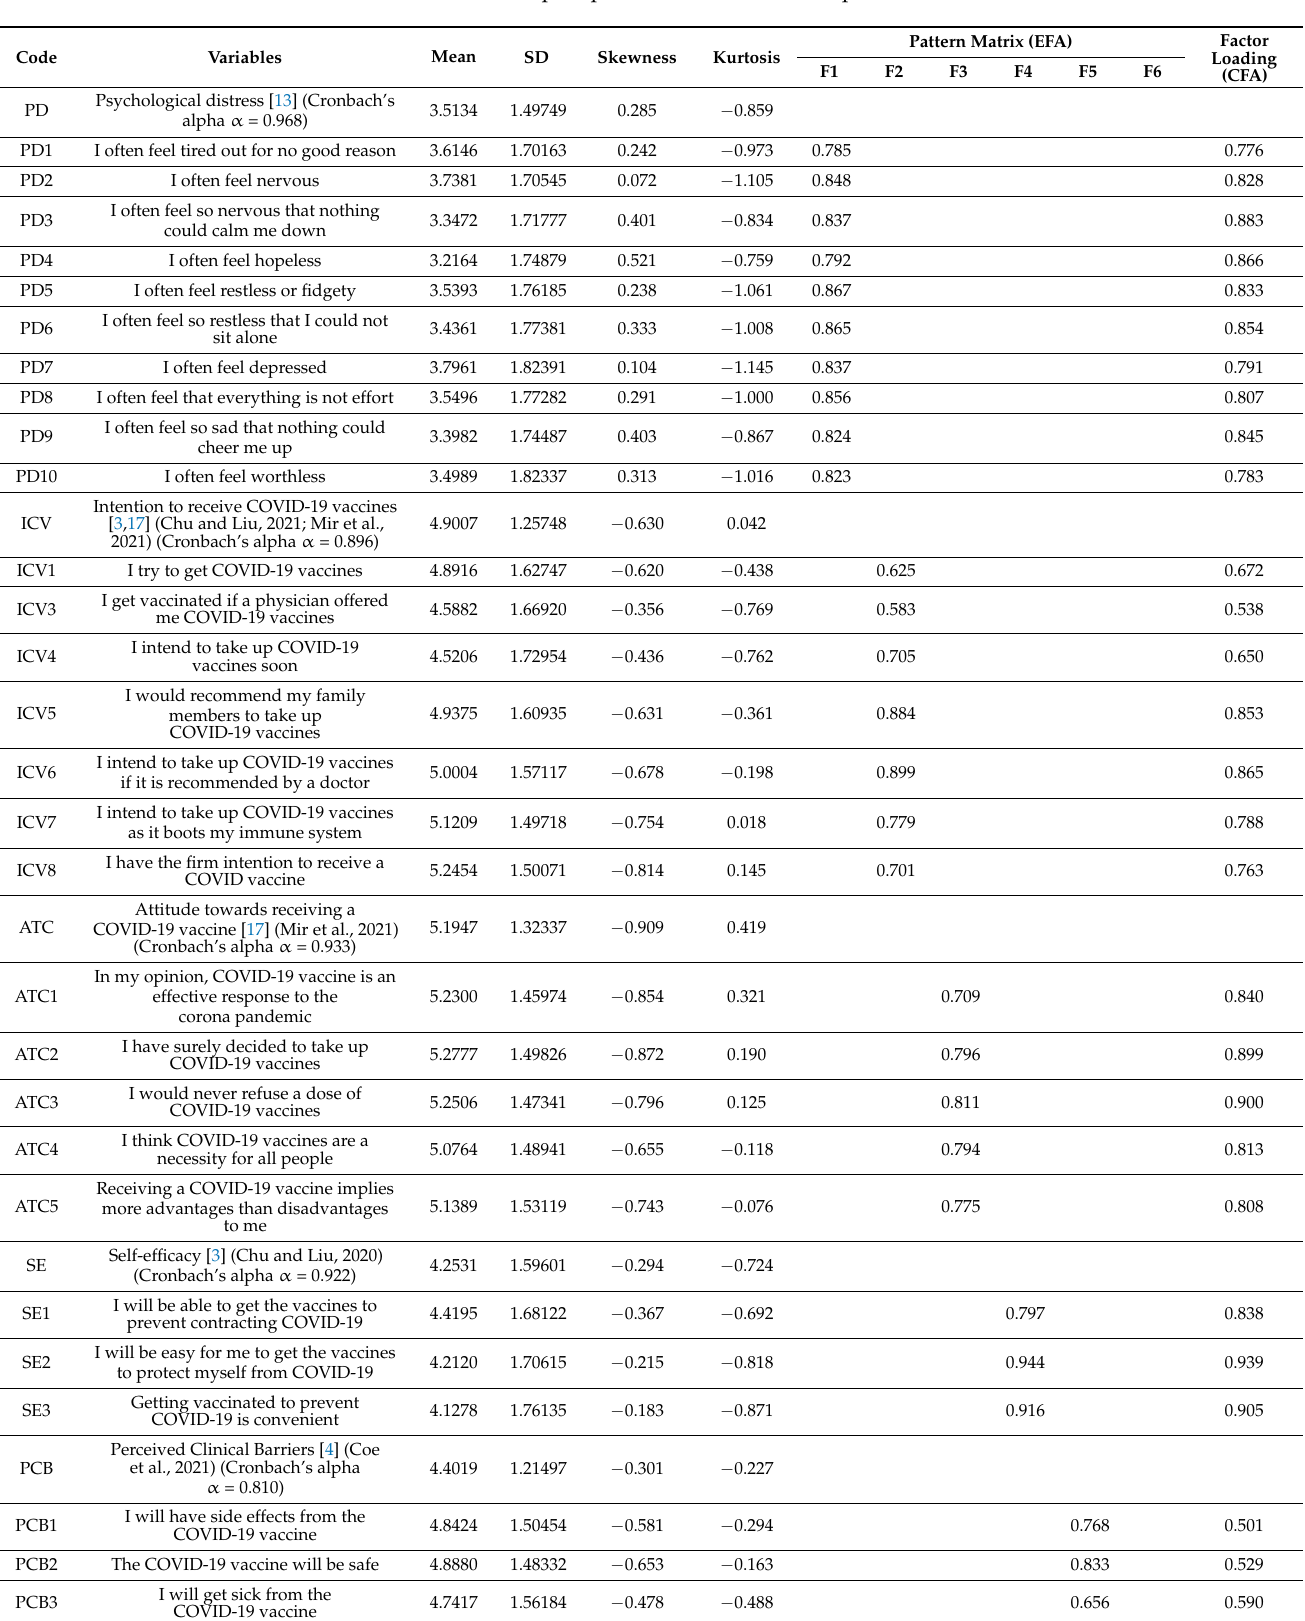
Table 2. Cronbach’s alpha, pattern matrix and descriptive characteristics of